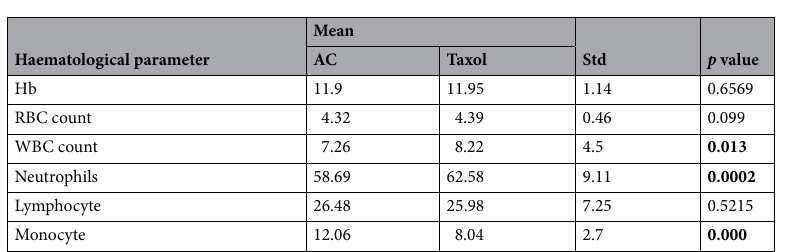
Table 3. Comparative mean-wise haematological parameters between AC (Adriamycin + cyclophosphamide) and Taxol-treated breast cancer patients. Values in the bold box represent a statistically significant p value.